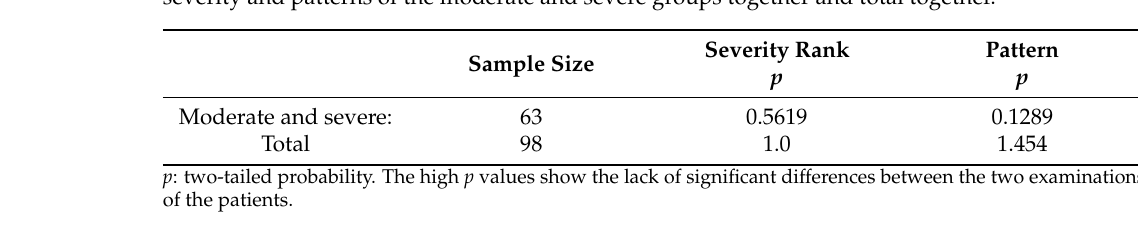
Table 3. Results of the Wilcoxon rank test of the paired samples of the first and second examination: severity and patterns of the moderate and severe groups together and total